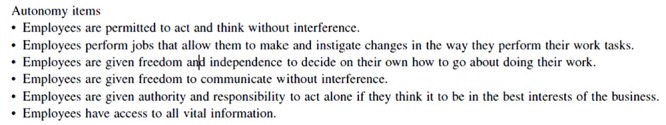
Autonomy items of Hughes and Morgan (2007).
Source:
Covin and Wales (2012).